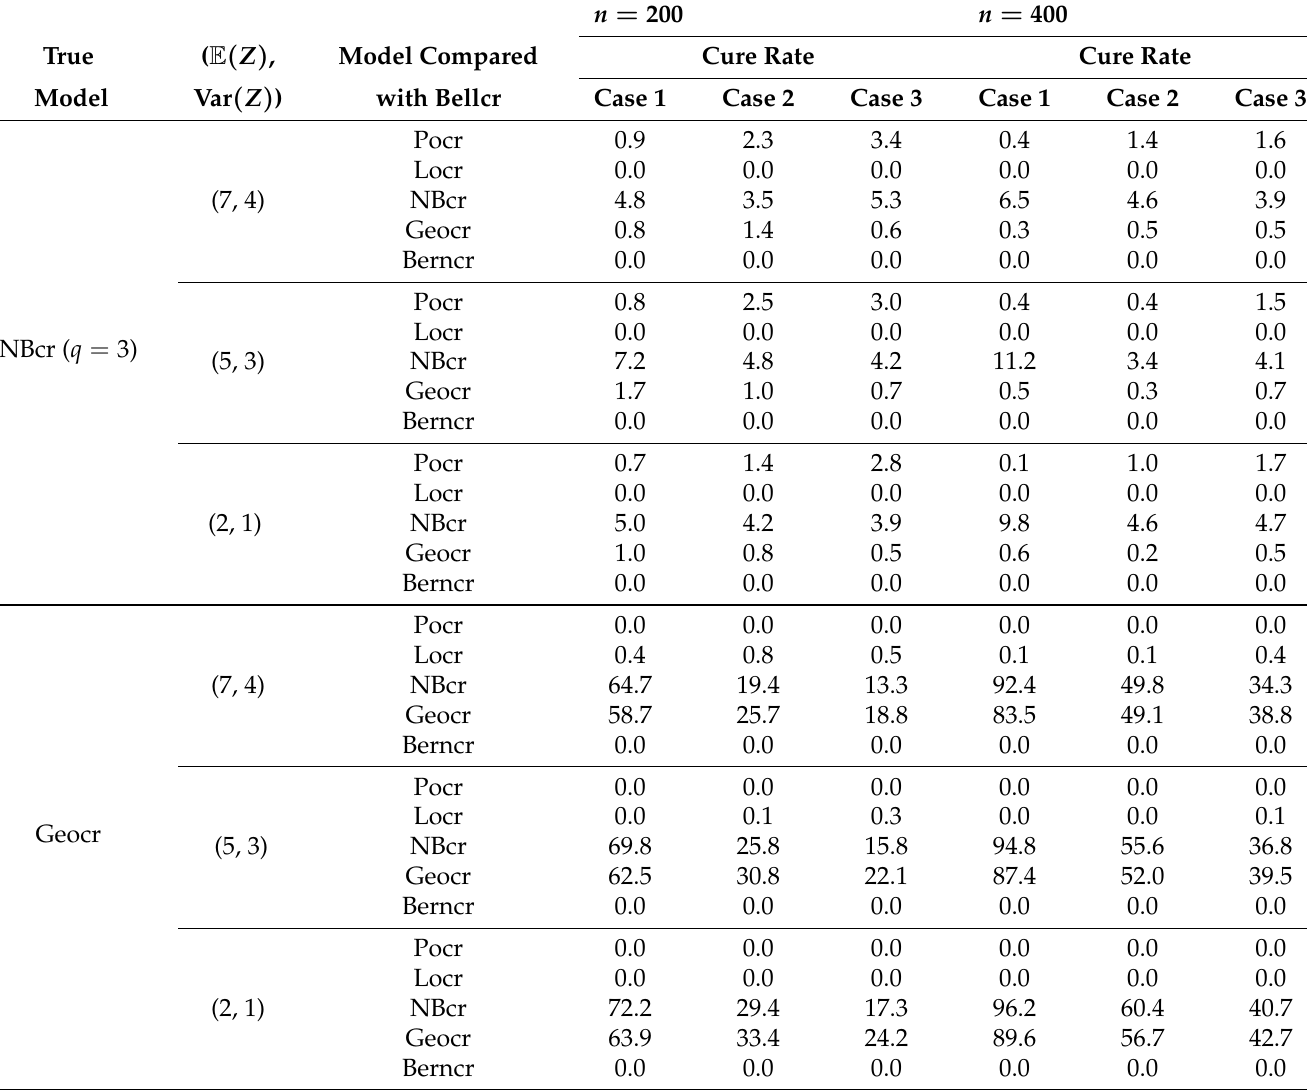
Table 5. Rejection rate (in %) of the Bellcr model when compared with different models using the Vuong’s test statistic—Part 2.